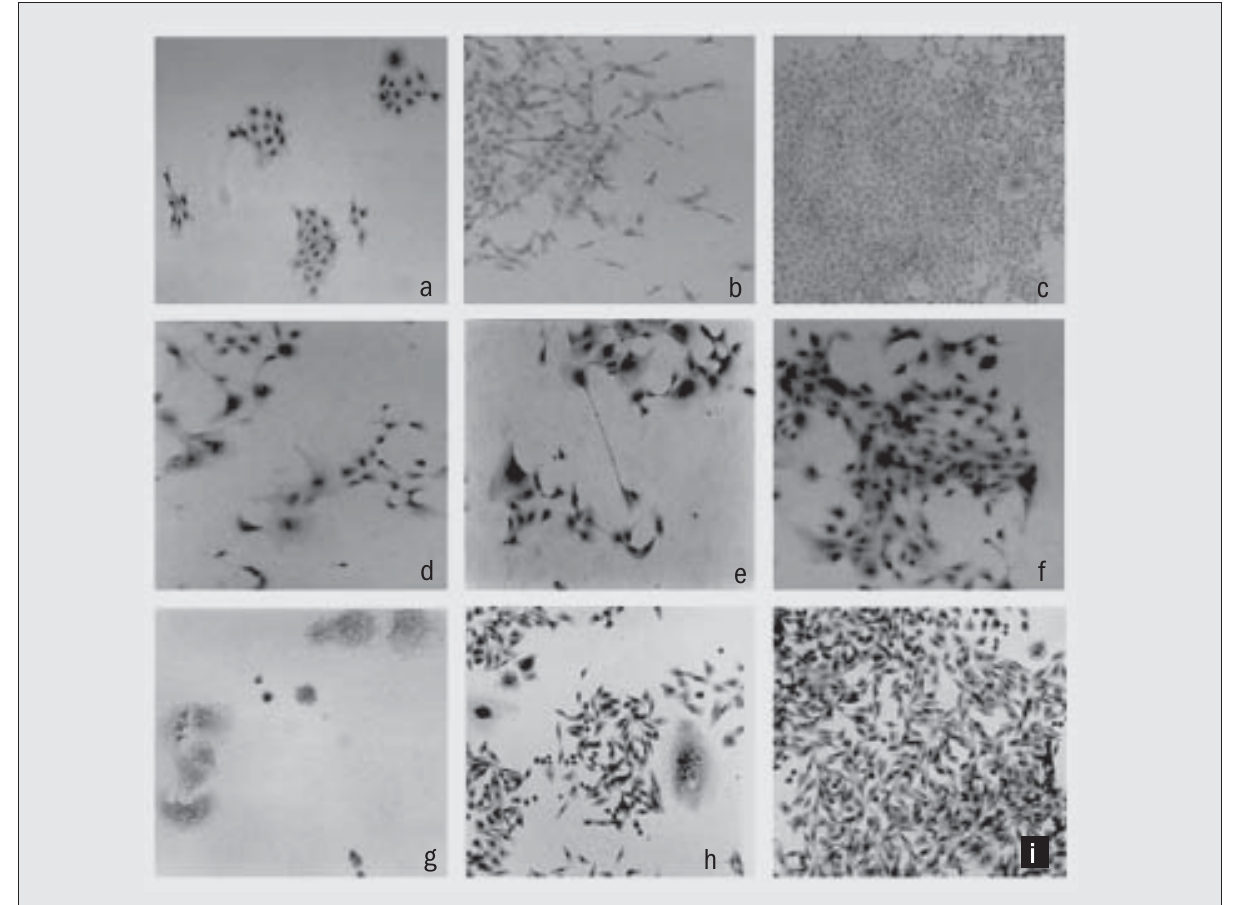
Figura 1 – Linhagens celulares em cultura de monocamada cultivadas em: baixa densidade (a, d, g); semiconfluência (b, e, h); e confluência (c, f, i). A seqüência mostra as linhagens MDCK (a – aumento de 12,5x; b, c – aumento de 15x), HN-5 (d, e, f – aumento de 25x) e HEp-2 (g – aumento de 50x; h, i – aumento de